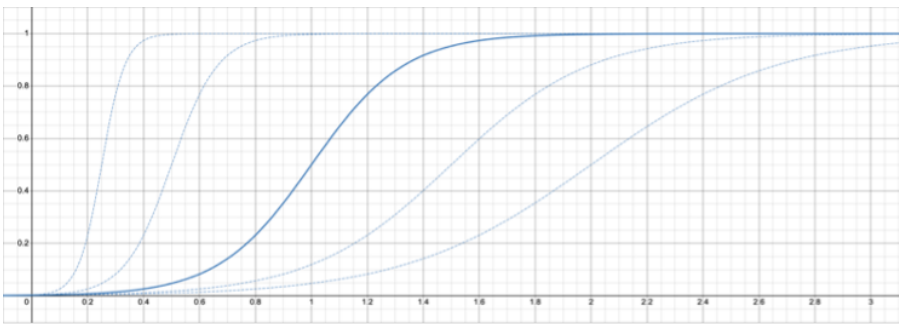
Figure 5. Logistic function normalized for δ x by its average value for the last N points in a sliding window, left to right: { 0.25,0.5,1,1.5 and 2 }